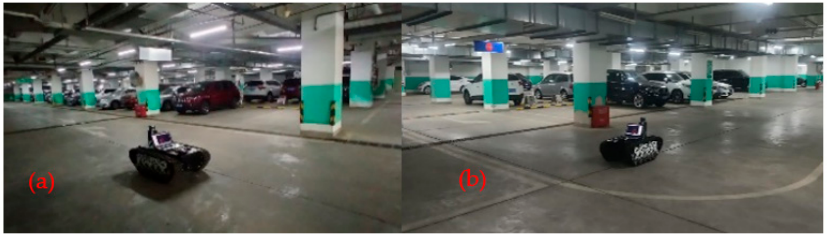
Figure 8. Experimental environment. ( a ) Scene #1 of Basement 1 parking lot; ( b ) Scene #2 of Basement 2 parking lot.